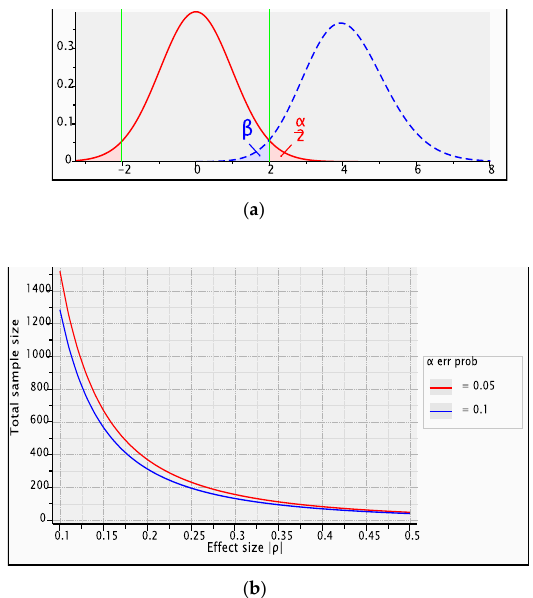
Figure 3. Computed statistical power ( a ) and validation by prediction of study power ( b ) by sample size ( n = 48) with β probability of type II error (false negative) and α probability of type I error (false positive).